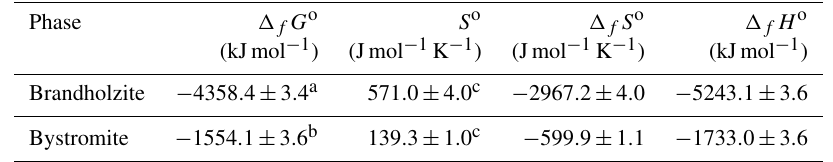
Table 9. Proposed best set of thermodynamic functions for brandholzite and byströmite at T = 298 . 15K. Phase